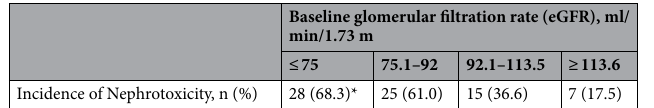
Table 2. Incidence of nephrotoxicity stratified by baseline creatinine clearance. * p =